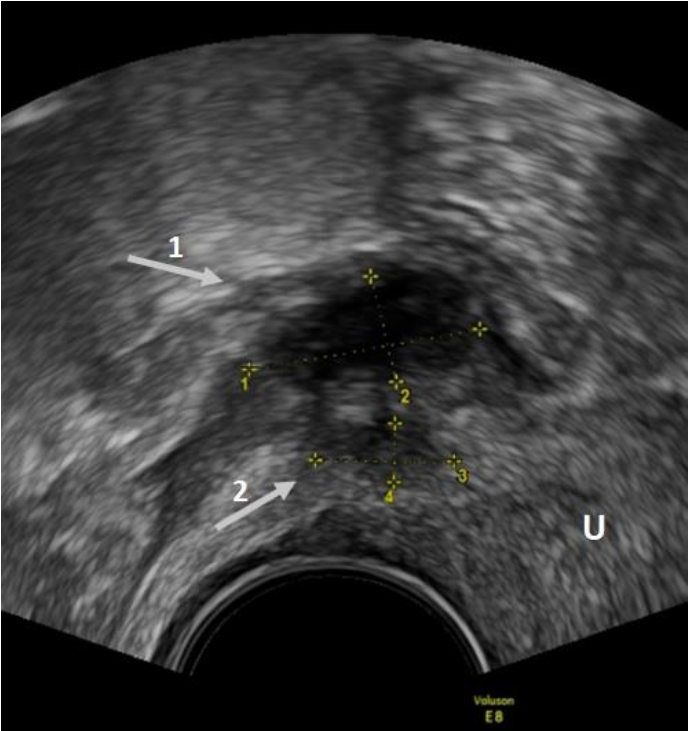
Figure 4. TVUS imaging method: the arrow and the calipers show a posterior vaginal fornix nodule in the sagittal plane. U: uterus.